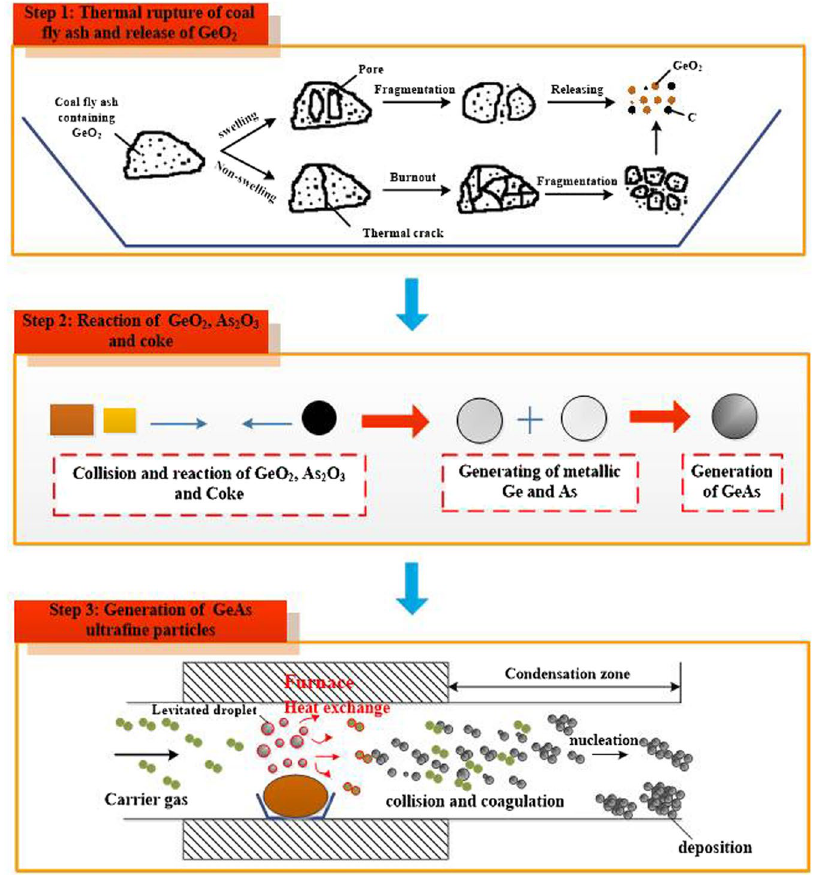
Figure 10. Mechanism of the formation of the GeAs ultrafine particles in the process of vacuum dynamic flash reduction and inert gas